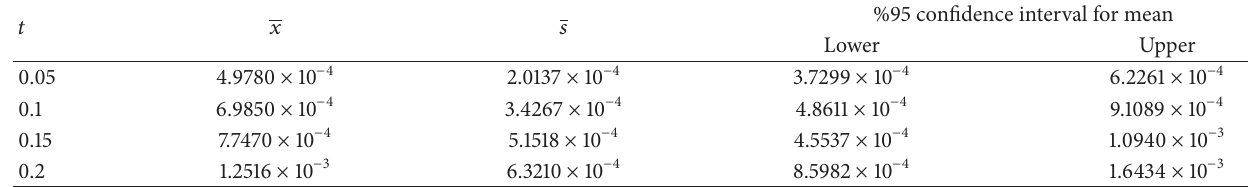
Table 6: Mean, standard deviation, and confidence interval for numerical solution mean ( 𝑇 = 0.25 , 𝐻 = 9/10 ).